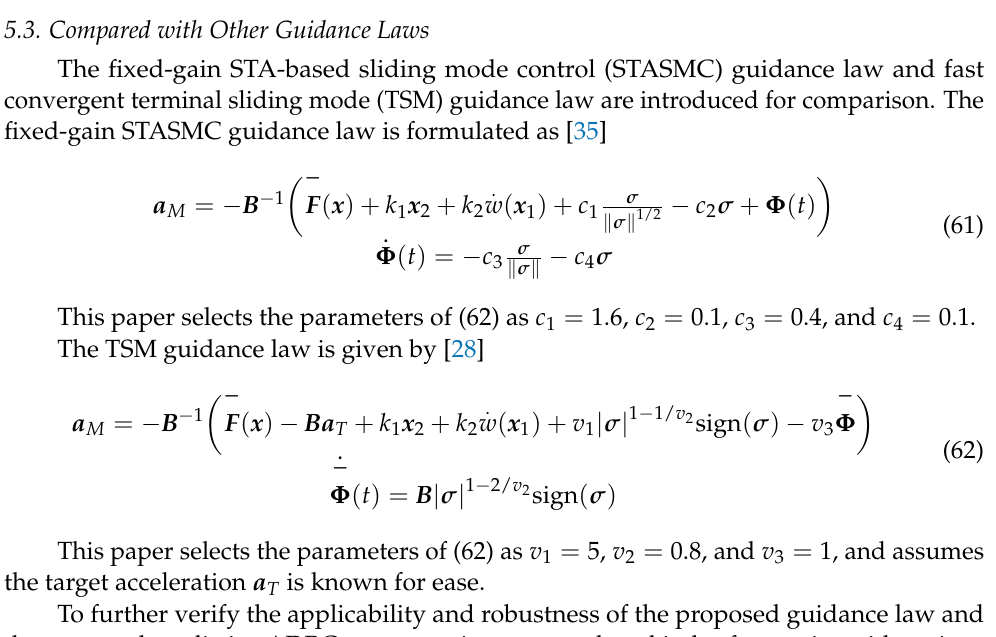
Figure 7. The performance of the proposed guidance law with different desired terminal elevation angles: ( a ) Relative distance trajectories; and ( b ) LOS angles.